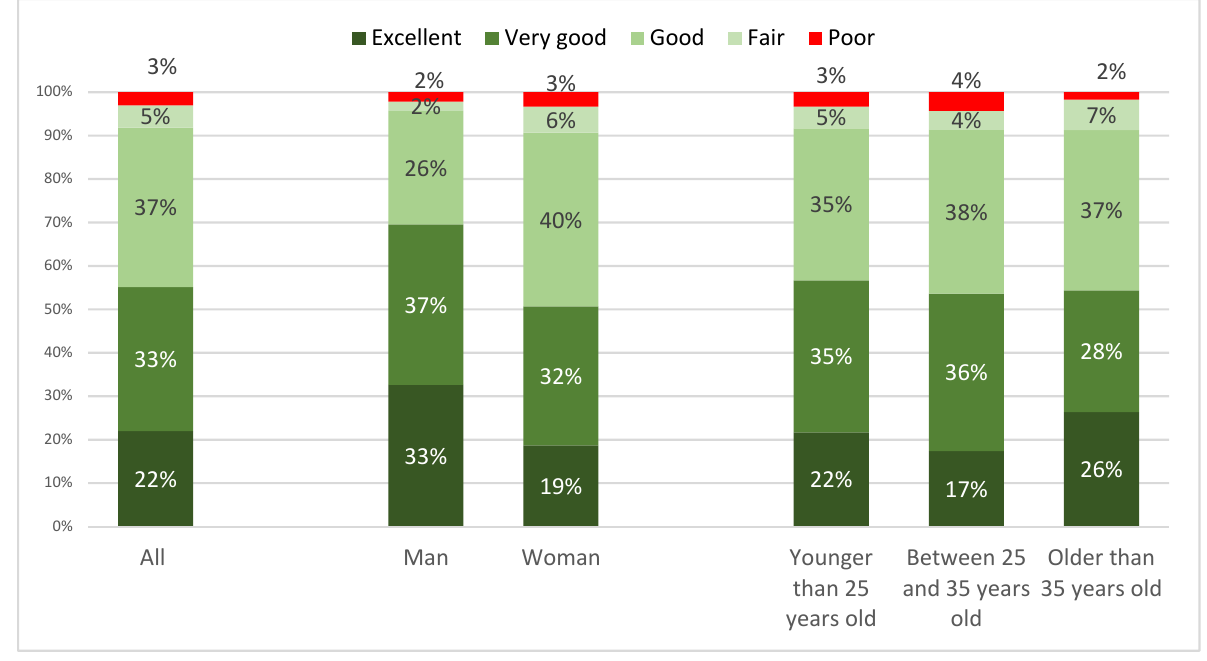
Figure 2. Self-rated health during COVID-19, by gender and age group, by percentage.